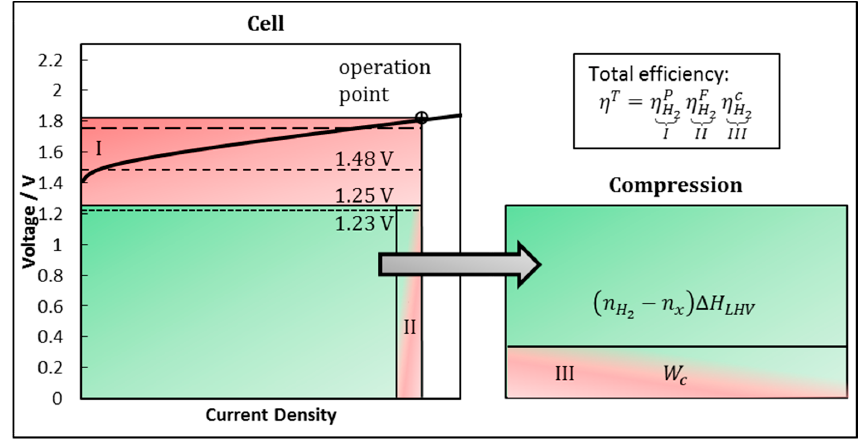
Figure 2. Left : The graph shows the cell voltage as a function of the current density. The areas symbolize incoming and outgoing power densities. The circle marks the operation point that is exemplarily set at 1.82 V. The green area, including area II, is the power density that is converted into chemical energy (hydrogen). For its generation, an additional power density is required that is supplied as electric energy and heat (area I). At 1.48 V, the heat released by the operation equals the required heat of combustion of the chemical reaction. In this example, the heat required to saturate the product gases with water is reached at 1.78 V, which is symbolized by a dashed line. While the cell voltage of 1.82 V is above this value, no external heat must be supplied; instead, cooling is needed to remove heat from the system. Area II marks the power density fraction that is lost due to permeation of product gases across the membrane, thereby reducing the amount of hydrogen originally generated. Right : The chemical energy of the produced hydrogen is given as the green area. Area III marks the required amount of energy for the compression of the gas.